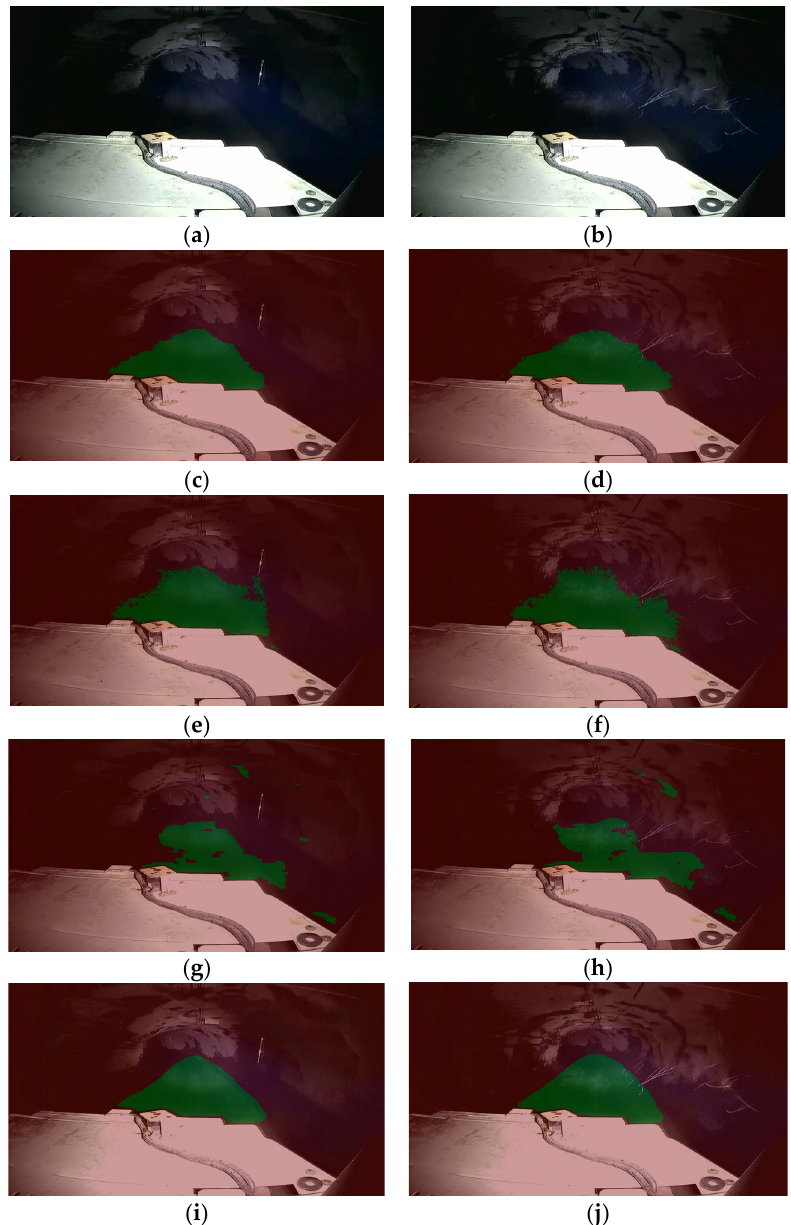
Figure 15. Comparison of the recognition effects of curved roads and sandy roads: ( a ) bend; ( b ) wind and sand; ( c ) SegNet_1; ( d ) SegNet_2; ( e ) ENet_1; ( f ) ENet_2; ( g ) BiSeNet_1; ( h ) BiSeNet_2; ( i ) BiSNet_improved_1; and ( j ) BiSNet_improved_2.